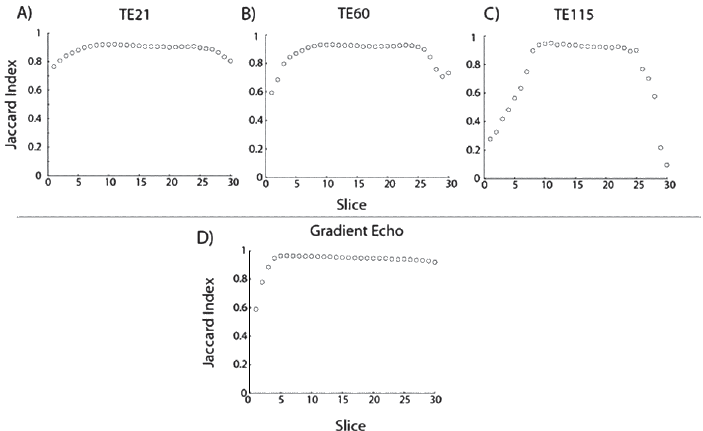
Fig 4. Plot of Jaccard index across slices. The index values represents the relative warping of the various images compared to the rescaled center slice MPRAGE image. A value of 1 represents minimal deviation compared to the corresponding MPRAGE image. A) EPI TE = 21ms, B) EPI TE = 60 ms, C) EPI TE = 115ms, and D) GRE TE = 30ms. A significant drop off in the index is seen in the outer slices of the EPI images, which worsens with longer echo times as